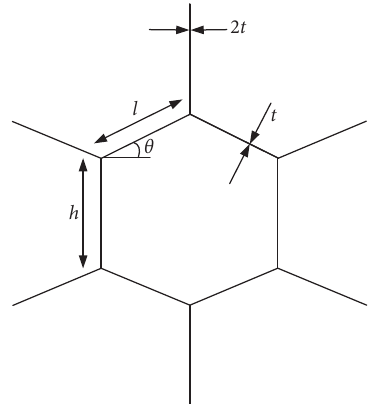
Figure 3: Hexagon double-walled honeycomb structure.